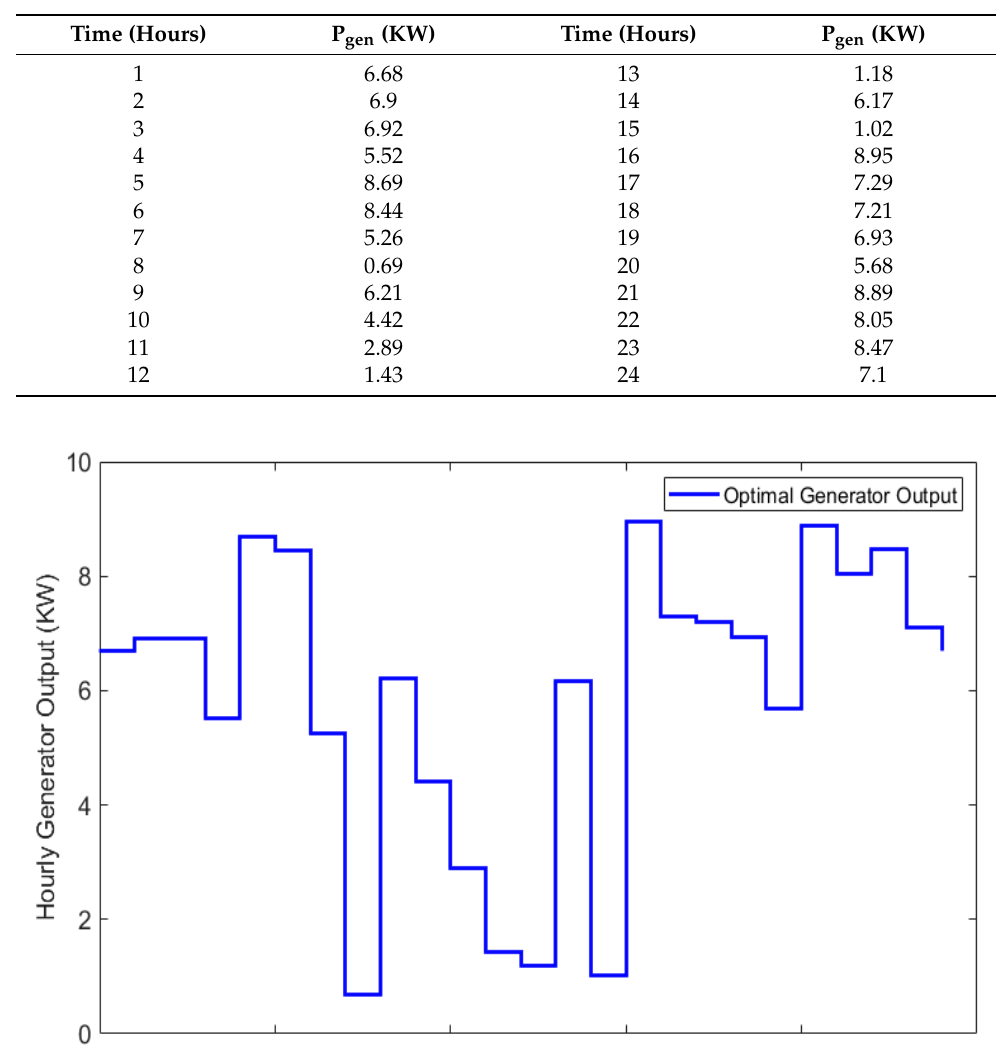
Table 7. Conventional generator power.